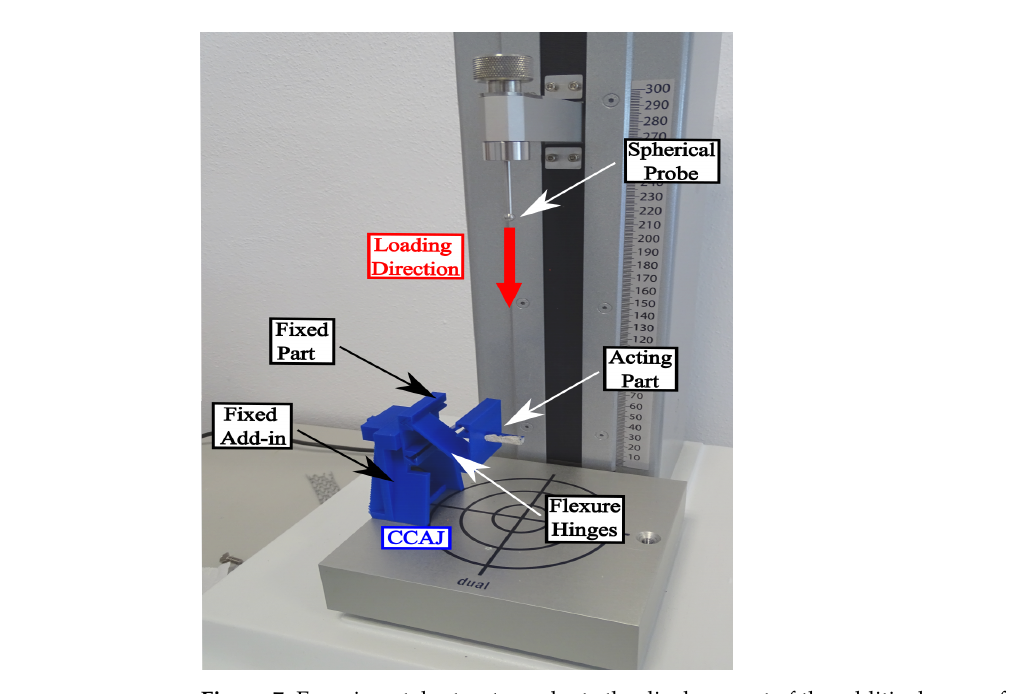
Figure 7. Experimental setup to evaluate the displacement of the additively manufactured compliant cross-axis joint.